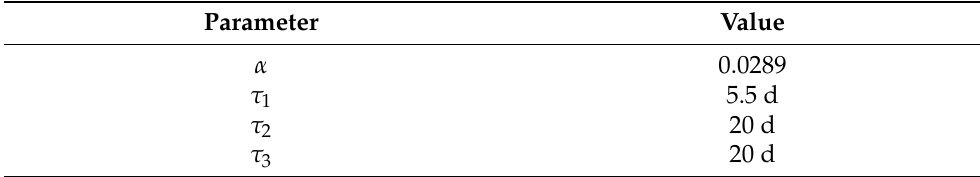
Table 3. Parameters adopted for the simulation in the case of